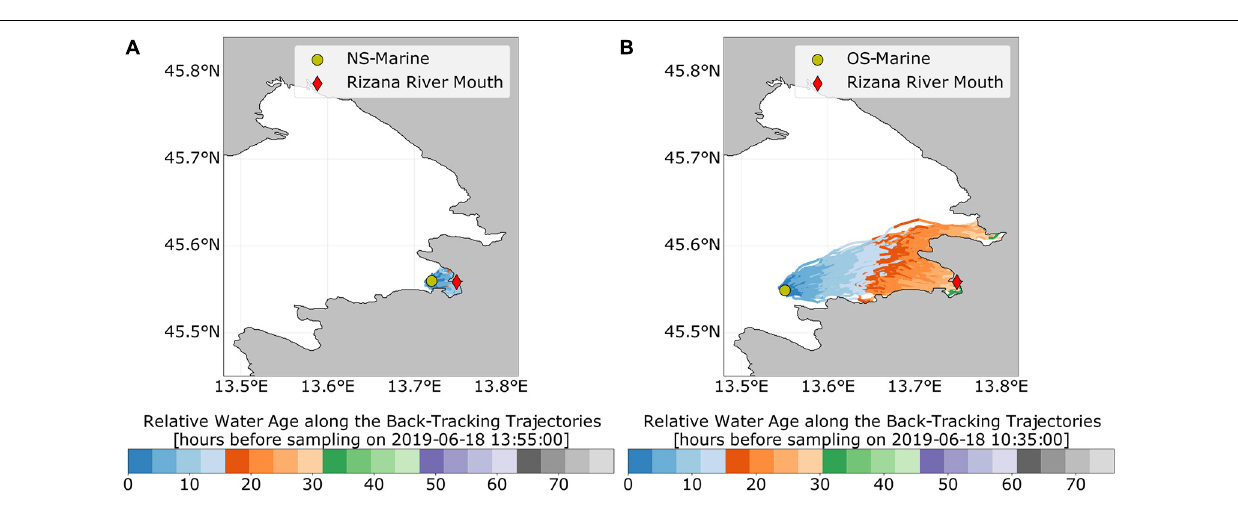
FIGURE 5 | Lagrangian backtracking of water masses from two sampling stations during summer sampling in 2019. (A) NS-Marine station, (B) OS-Marine station. In each figure, the sampling station is marked by a green circle and the mouth of the Rižana river with the red diamond. The trajectories indicate from where the water masses may have arrived to the sampling location prior to the respective sampling time. Each trajectory is colored by relative water age prior to the sampling